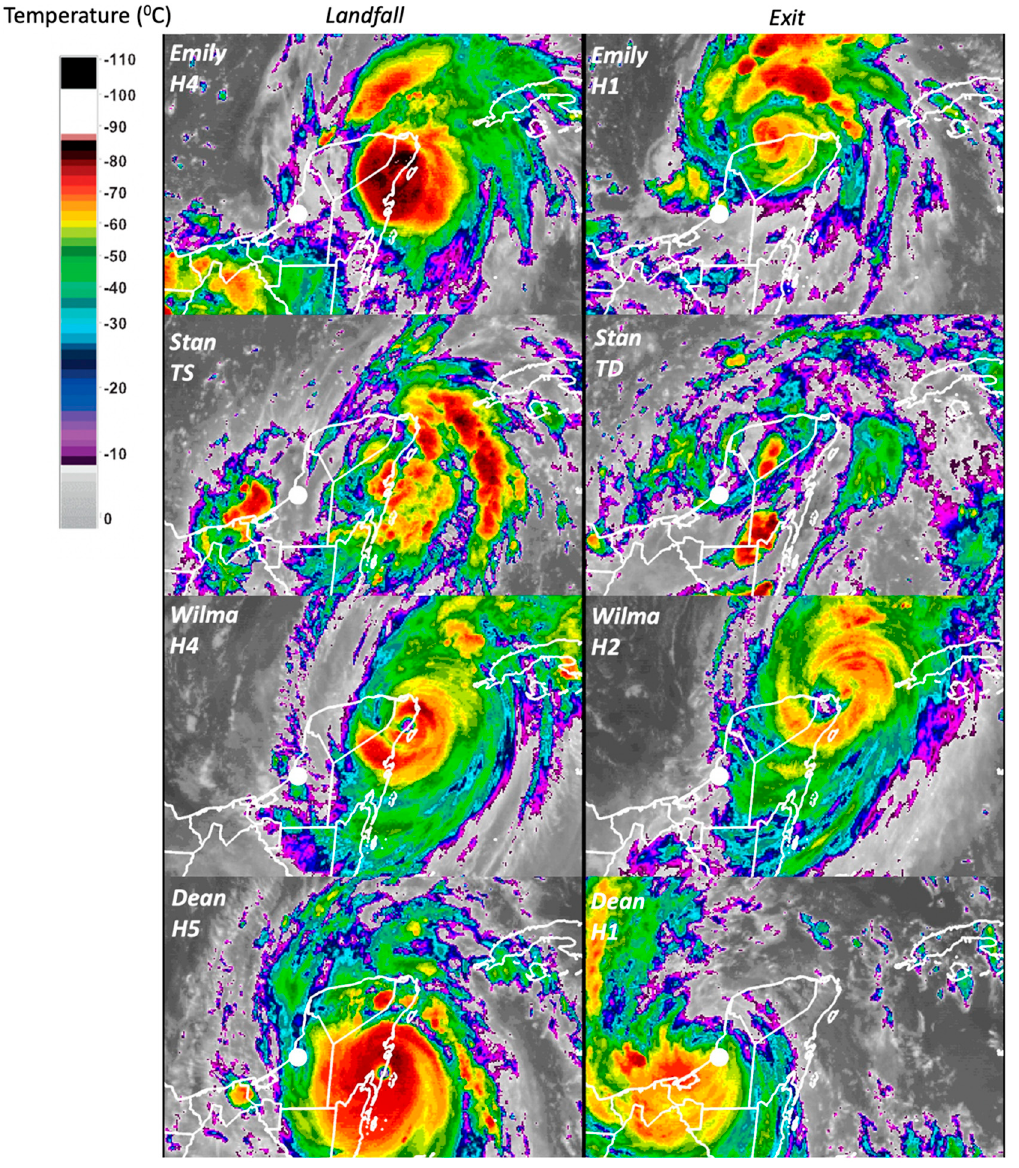
Figure 6. Geostationary Operational Environmental Satellite-12 (GOES-12) imagery from tropical cyclones Emily, Stan, Wilma, and Dean. Left-side images show near landfall time while the right-side imagery show when each tropical cyclone moved into the Gulf of Mexico. Colors represent a calibrated scale of cloud-top temperature (°C); the white dot is the Canasayab gauge station location in the Champoton River watershed, Campeche (Figure 2). For GOES-12 images’ animation, see weblinks in Table S2.